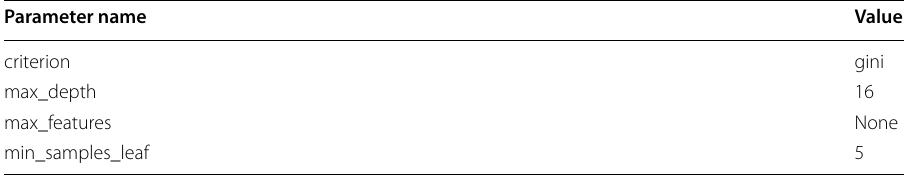
Table 71 Modes of DT tuned hyperparameter values for experiments with the information theft dataset